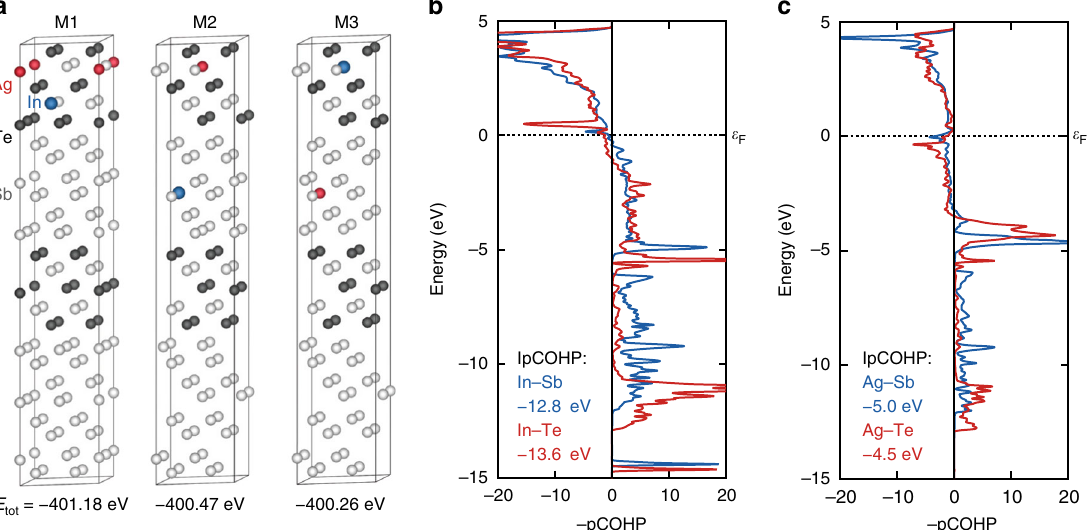
Fig. 4 Total energy and bonding analysis of AIST with different arrangements. a structural images of three typical AIST models (M1 – 3) including their total electronic energy. b projected COHP (pCOHP) plots of In – Te (red) and In – Sb (blue) interactions in models M1 and M2, respectively. c pCOHP plots of Ag – Te (red) and Ag – Sb (blue) interactions in models M1 and M3, respectively. The integral of the pCOHP up to the Fermi level (IpCOHP) is shown to better quantify the results. The energy axes are referenced to the Fermi level ε